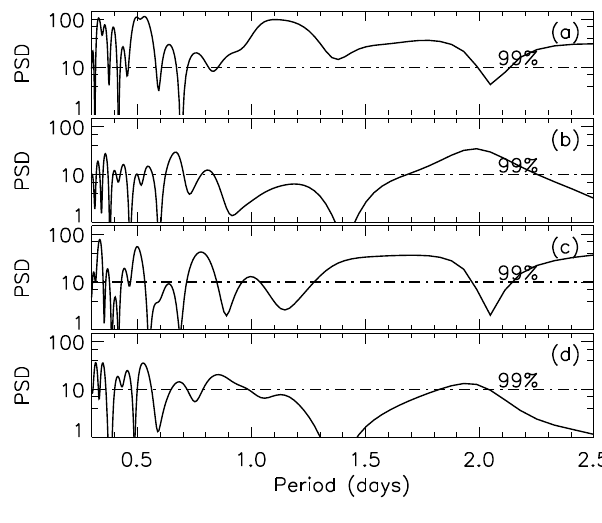
Fig. 1. Lomb-Scargle periodogram calculated for the zonal electric field for (a) 20–24 January, (b) 27–31 January, (c) 17–21 February, and (d) 24–28 February, in 2003. The horizontal (dash dot) line indicates the level of 99% of confidence (=9.90mV 2 /m 2